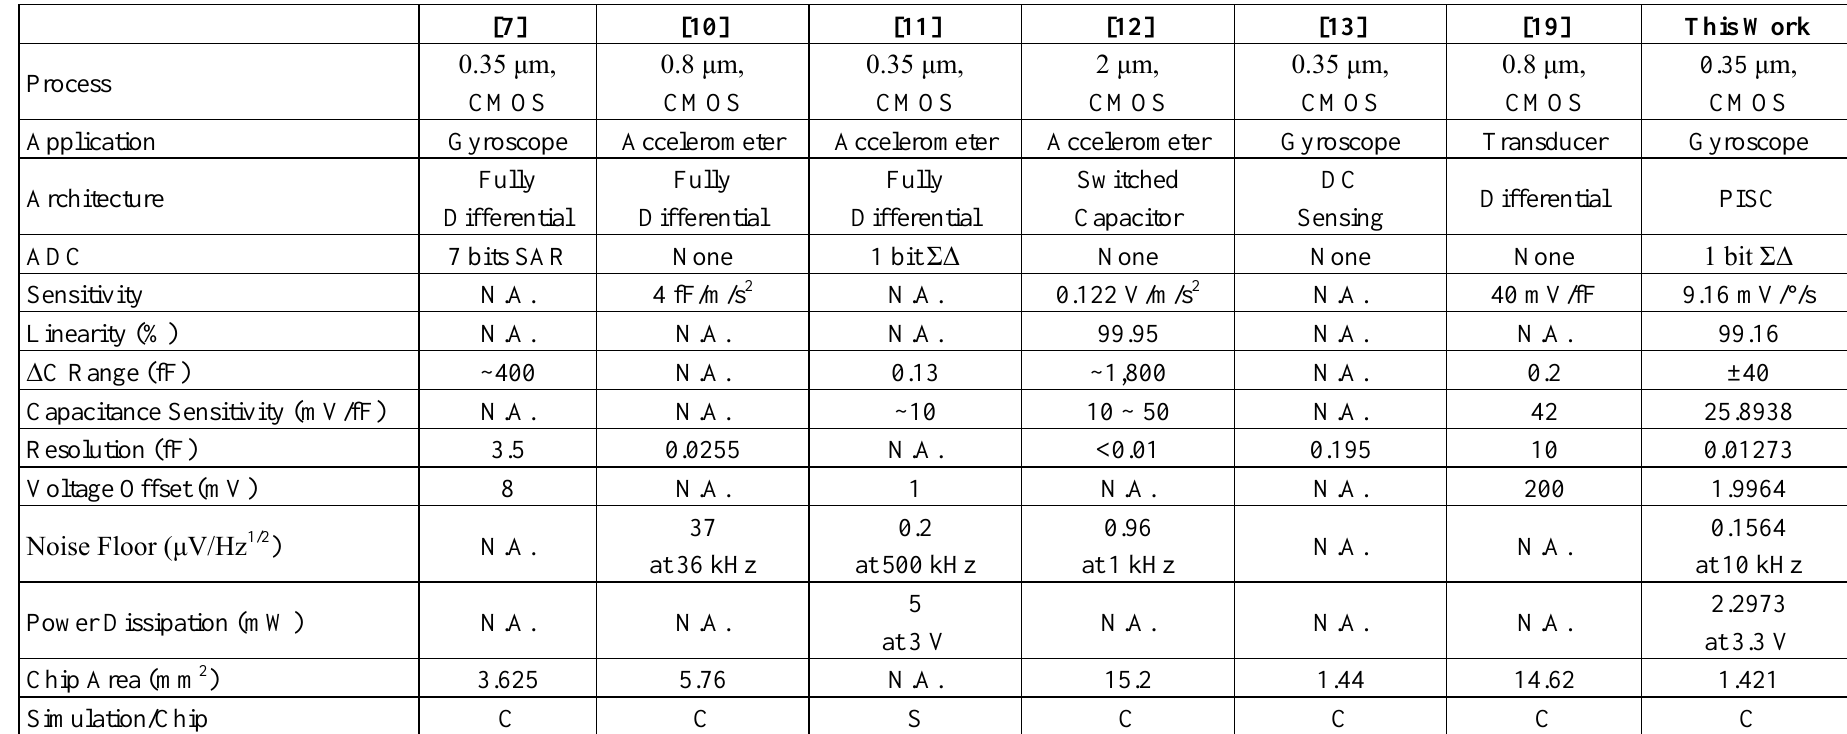
Table 7. Comparison with CMOS capacitive sensing circuits in the